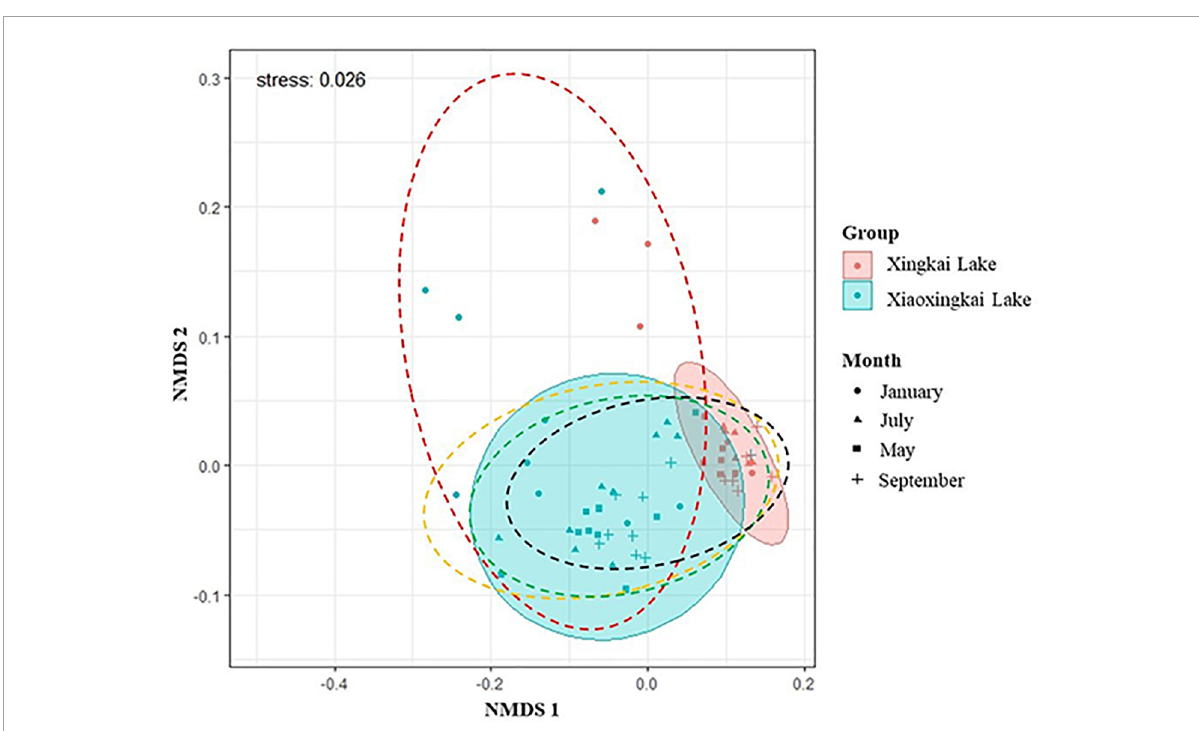
FIGURE3 Ordination diagrams for non-metric multidimensional scaling of heavy metals in Xingkai Lake and Xiaoxingkai Lake in 4 months. The distance between points represents the similarity degree in heavy metal composition. Metals in January, May, July, and September are enclosed by red, orange, green, and black dotted lines. Metals in Xingkai Lake and Xiaoxingkai Lake are enclosed by pink and cyan circles. Stress = 0.026.